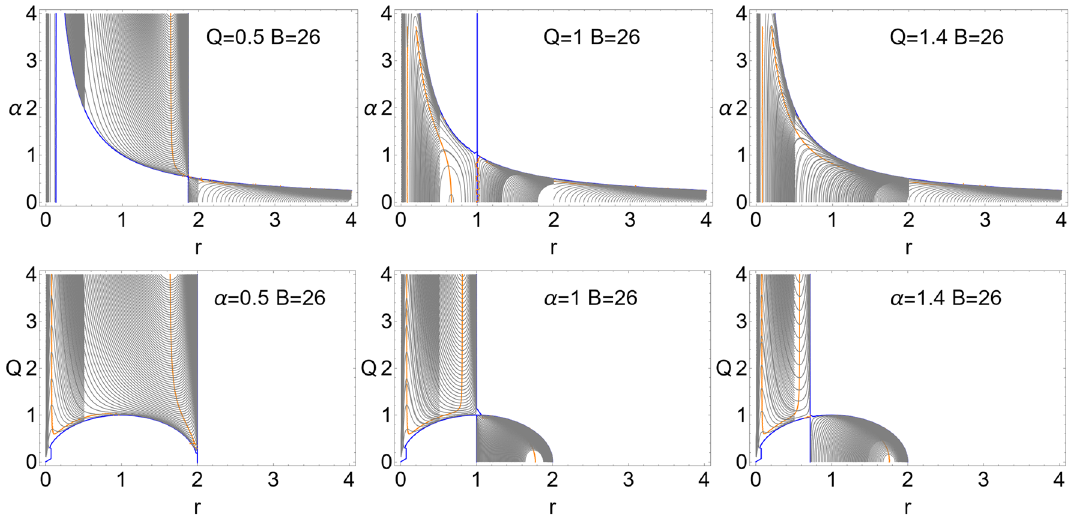
field strength, and α and Q are acceleration and charge